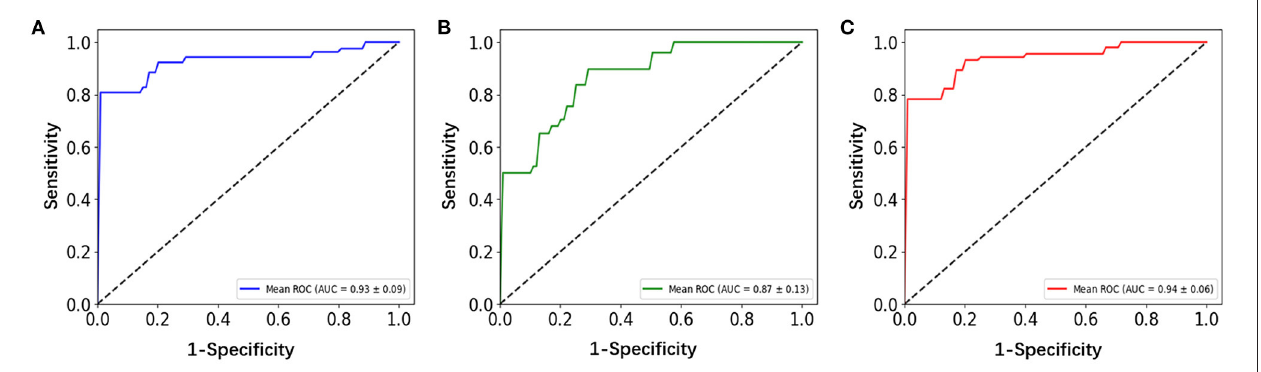
FIGURE 4 | ROC curves assessing Pearson correlation, partial correlation, and distance correlation performance by using SVM. (A) Pearson correlation, (B) partial correlation, and (C) distance correlation. ROC, receiver-operating characteristic; SVM, support vector machine.